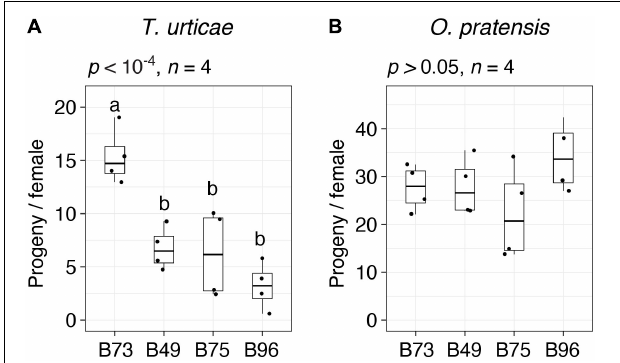
FIGURE 2 | Spider mite resistance profiles for B73, B49, B75, and B96. Indicated is the number of progeny per adult T. urticae female (A) and O. pratensis female (B) for each of the four maize lines after 6 days of feeding in enclosures on the 8th and 9th leaves (boxplots with overlay of data points are shown; sample size, n , refers to the number of plants used). Where significant variation was observed by ANOVA ( p < 0.05), pairwise significance was assessed with correction for multiple testing using the Hochberg method (different letters denote significant differences at p <